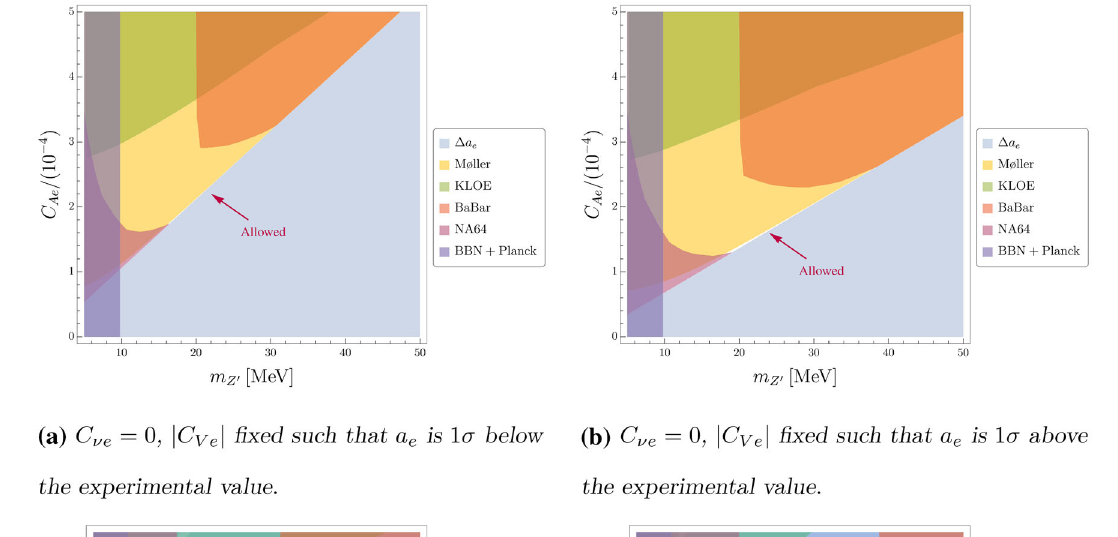
space remains, indicated by the red arrow. In the lower plots the allowed neutrino coupling is shown, with zero vector coupling C Ve = 0, and axialcoupling C Ae > 0suchthatthecontributionofthe Z (cid:2) loopinduces a value of a e which is c 1 σ below, and d 1 σ above the experimental